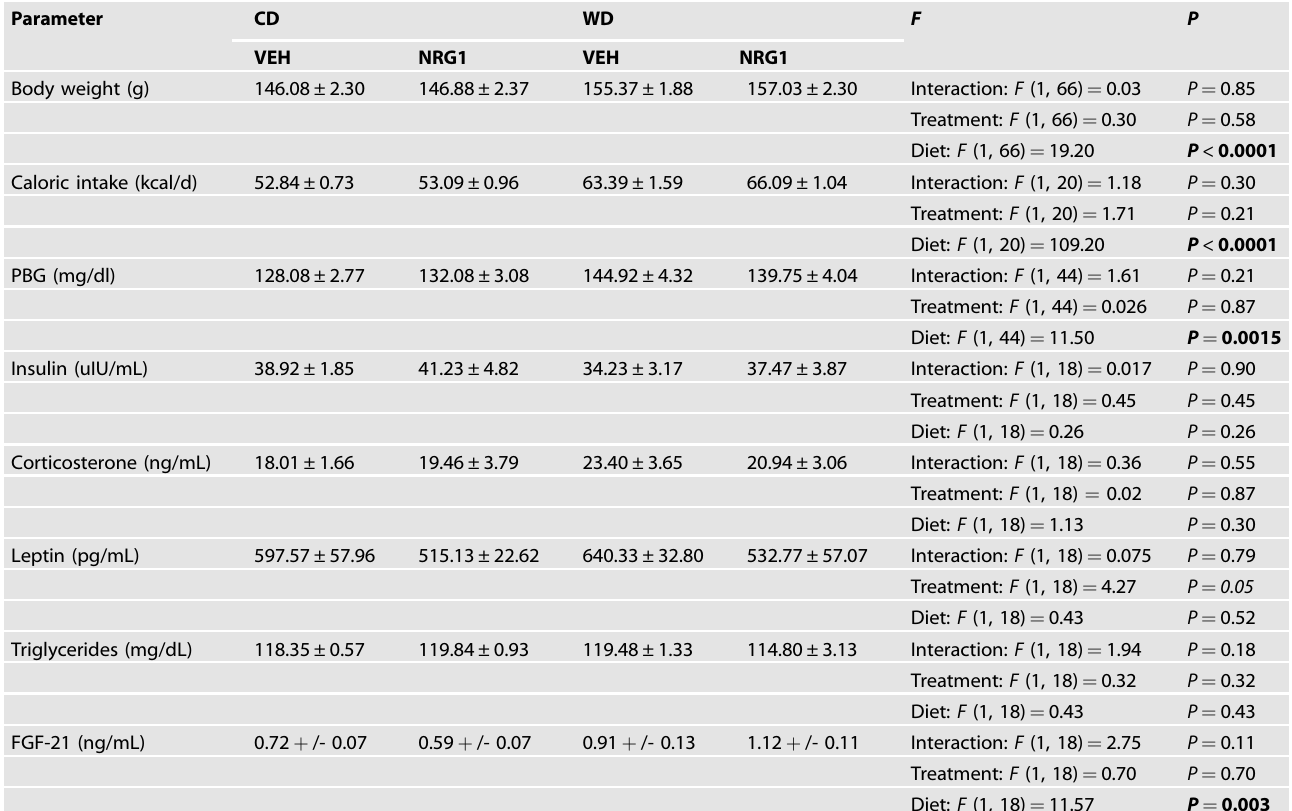
Table 1. Detailed biometric parameters fi ndings and